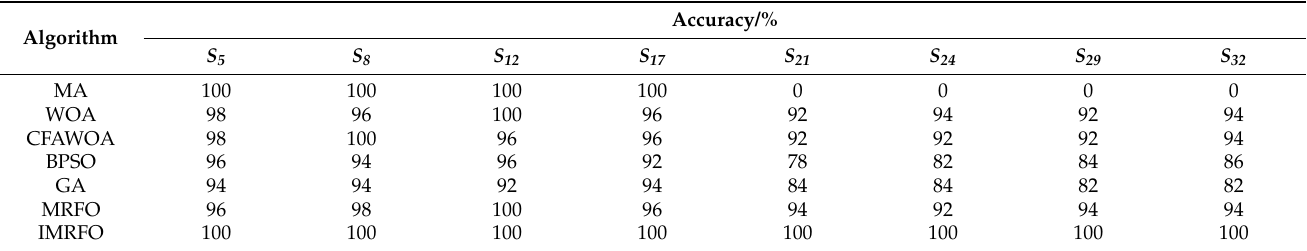
Table 9. Single fault location result.